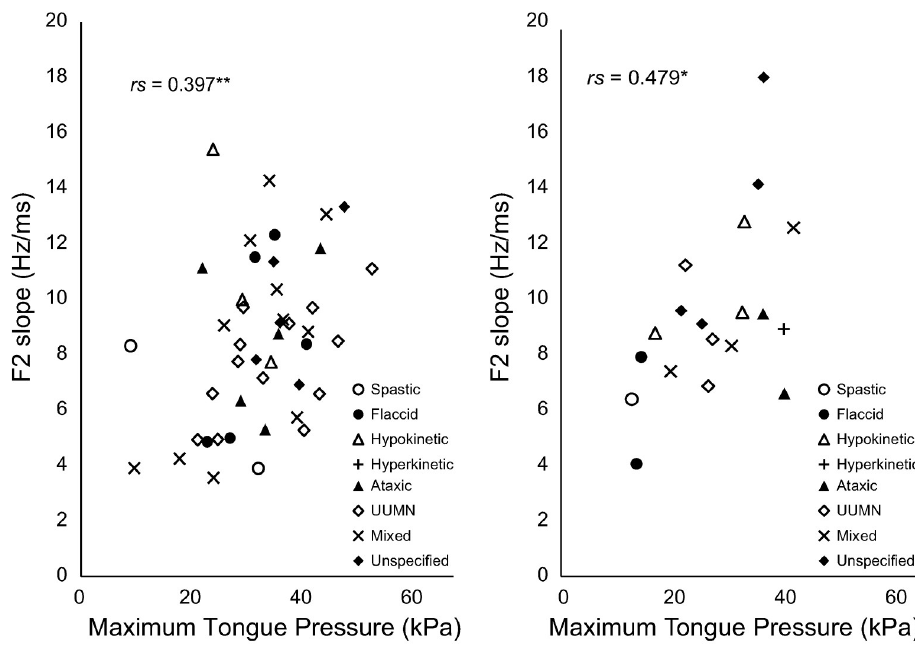
Fig 3. Bivariate scatter plot of maximum tongue pressure and second formant (F2) slope in male speakers with dysarthria (left) and female speakers with dysarthria (right). UUMN, unilateral upper motor neuron. � p < 0.05, �� p < 0.01. The plot shows the subtypes of each speaker with dysarthria. White circles, spastic; black circles, flaccid; white triangles, hypokinetic; crosses, hyperkinetic; black triangles, ataxic; white diamonds, UUMN; X, mixed; and black diamonds, unspecified types.